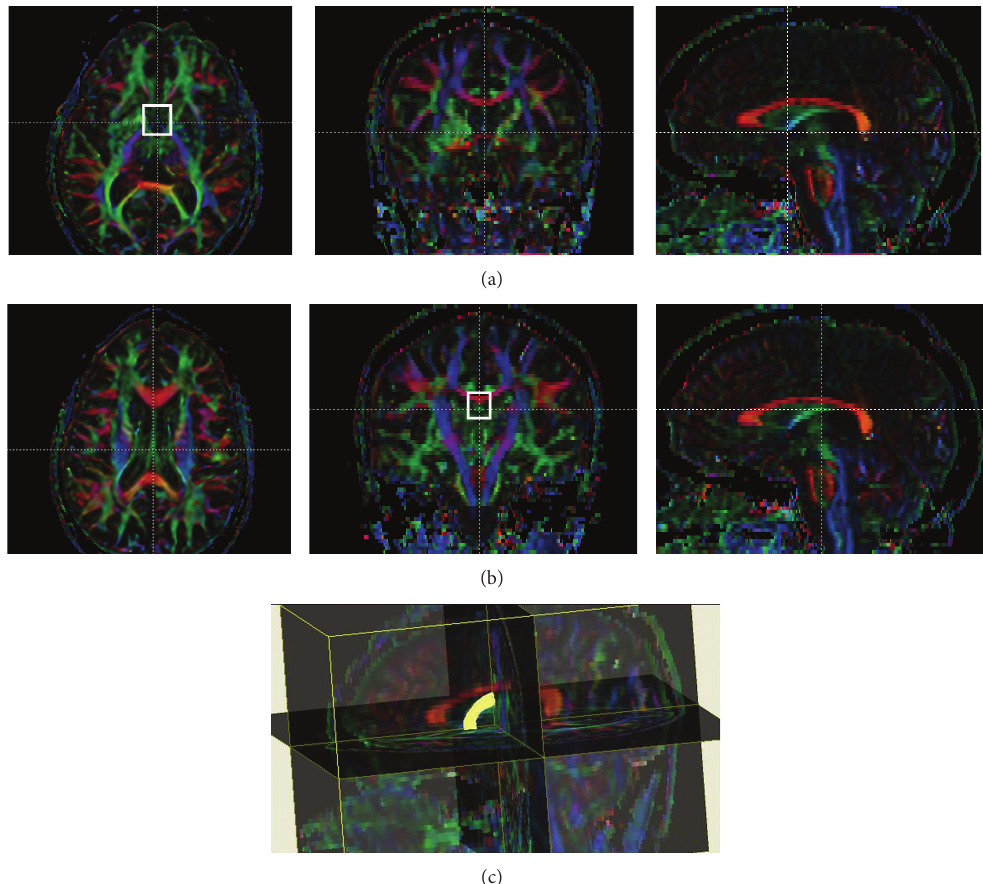
Figure 1: Tractography of the fornix. Regions of interest used for tractography of the fornix were drawn one axial slice above the anterior commissure (a) and at the hippocampal commissure on coronal reconstructions of the DTI color maps (b). Streamlines were required to pass through both regions of interest and were terminated at those points. Three-dimensional reconstruction of the fornix in an MS case